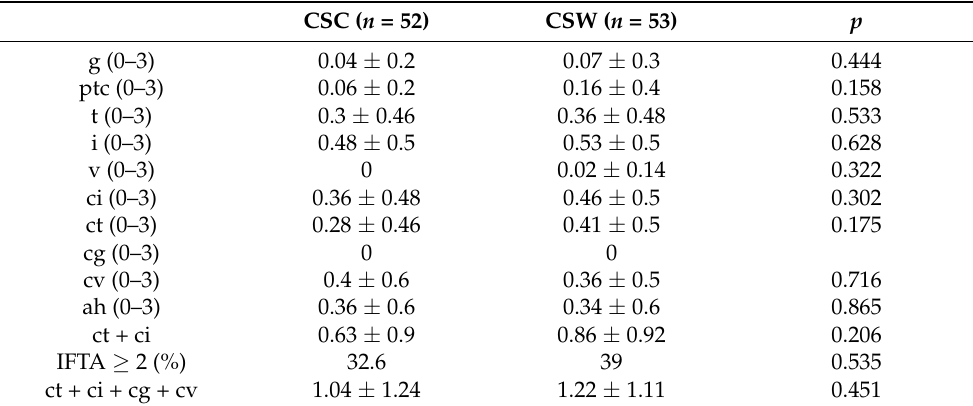
Table 2. Banff scores in the baseline protocol biopsy at 3-months post-transplant.